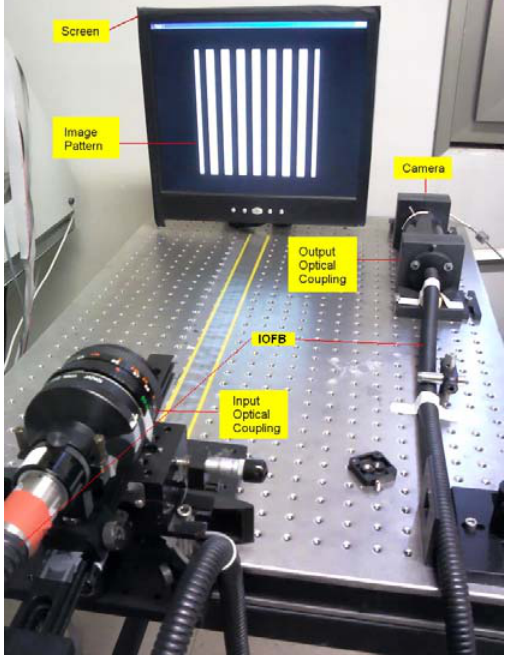
Figure 1. Structure of a typical calibration/transmission IOFB